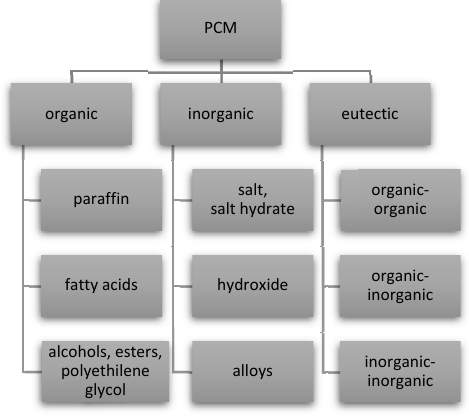
Figure 3. Types of PCMs [21].